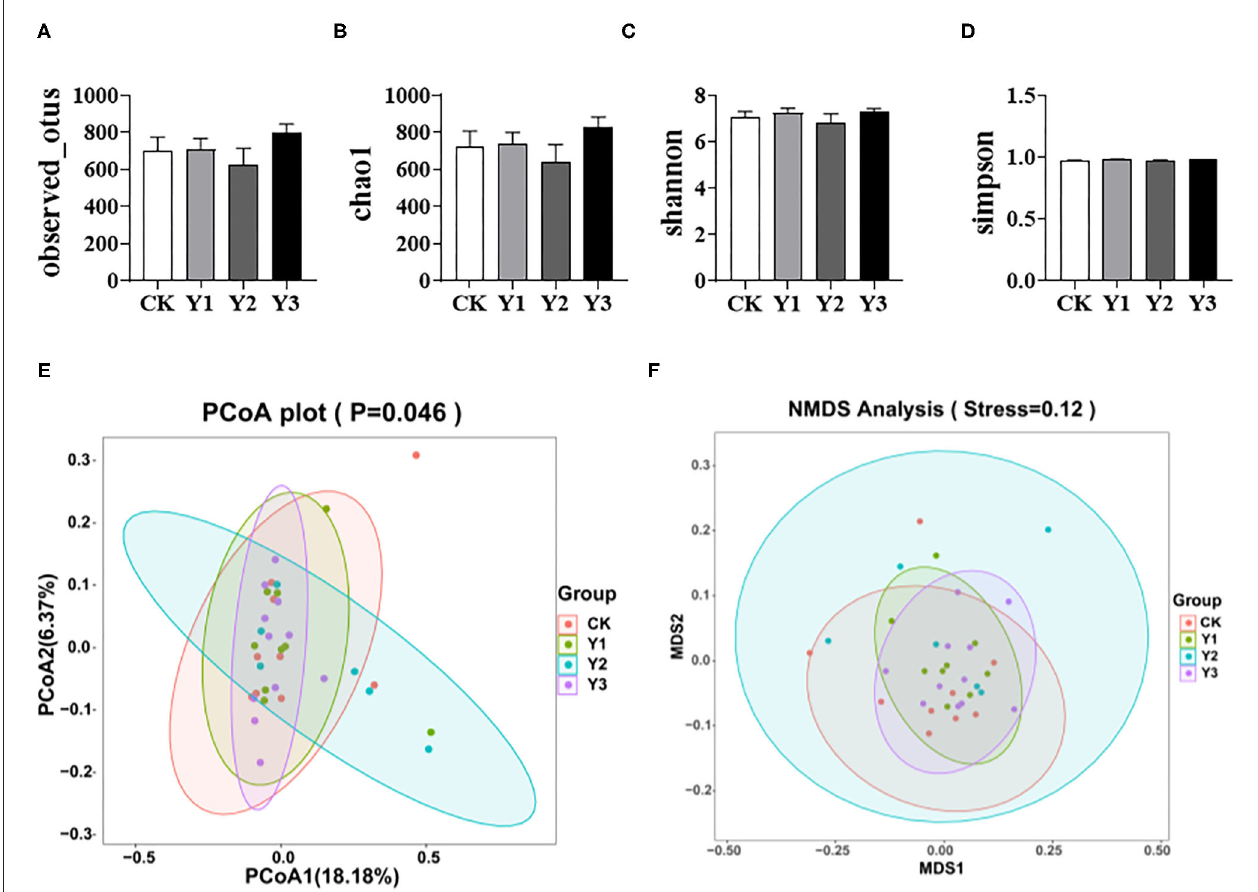
FIGURE 3 | Effects of dietary AOE on alpha diversity and beta diversity of cecal bacterial community of ducks. (A–D) Alpha diversity including observed otus, chao1, shannon, and simpson indexes. (E,F) Beta diversity including Principal Coordinate Analysis (PCoA) and Non-metric multidimensional scaling (NMDS).